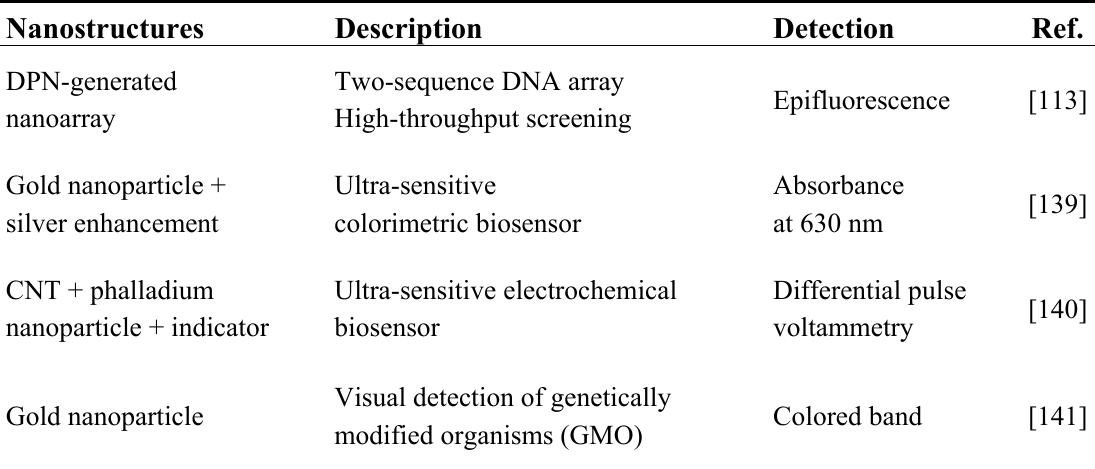
Table 4. Detection of DNA hybridization at the